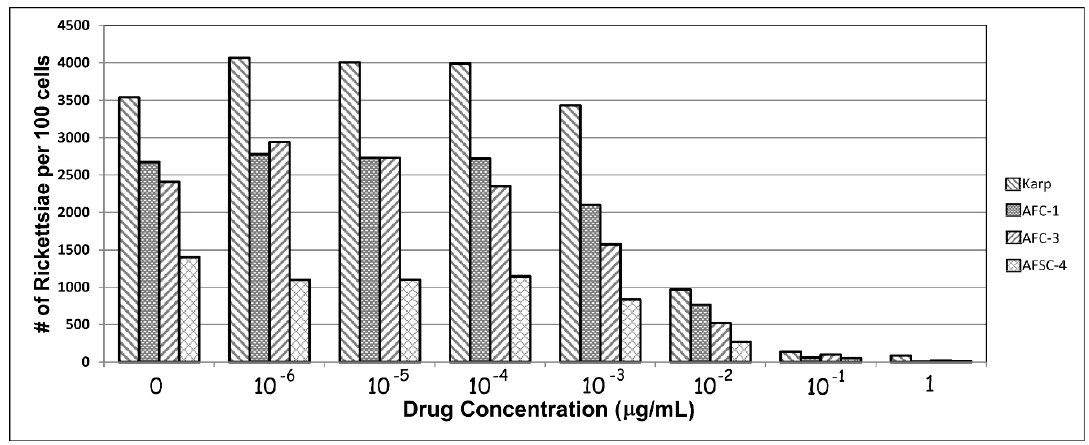
Figure 1. In vitro responses of isolates of O. tsutsugamushi to various levels of doxycycline following 72 h of incubation.